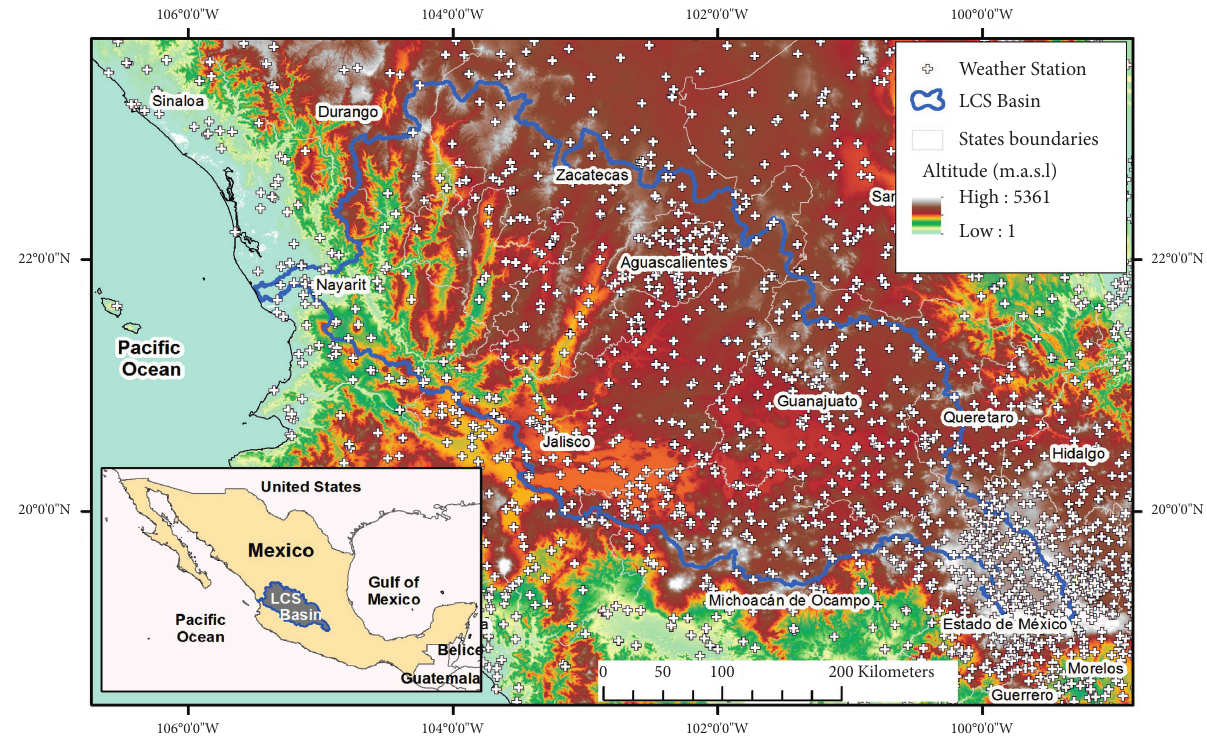
Figure 1: Lerma-Chapala-Santiago